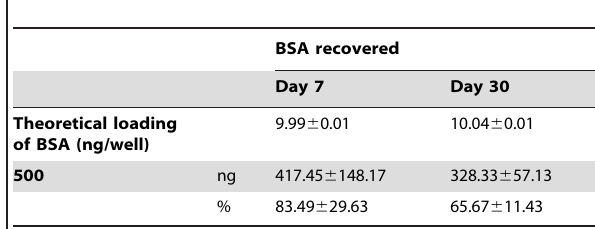
Table 7. Analysis of total BSA content in SA MNs after different storage periods, where the BSA content was determined using SDS-PAGE (means 6 S.D., N= 6; the average band intensity of the fresh BSA stock was used as the standard for the determination of the BSA recovery on days 7 and 30).